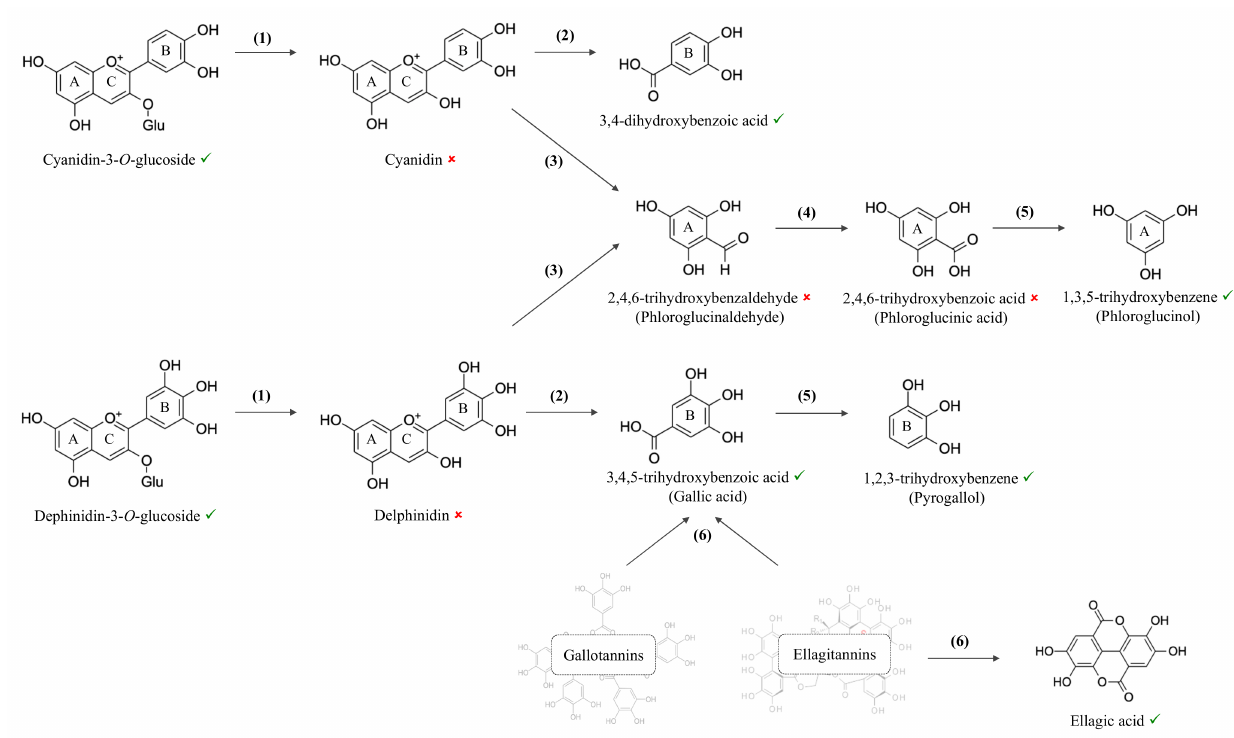
Figure 5. Proposed reaction pathways of phenolic compounds from jaboticaba juice during storage. Anthocyanins may undergo deglycosilation (reaction 1), followed by ring cleavage (reactions 2 and 3), oxidation (reaction 4) and decarboxylation (reaction 5), while tannins may undergo hydrolysis/depolymerization (reaction 6). Compounds marked with (cid:51) and (cid:55) were observed and not observed in the juice,